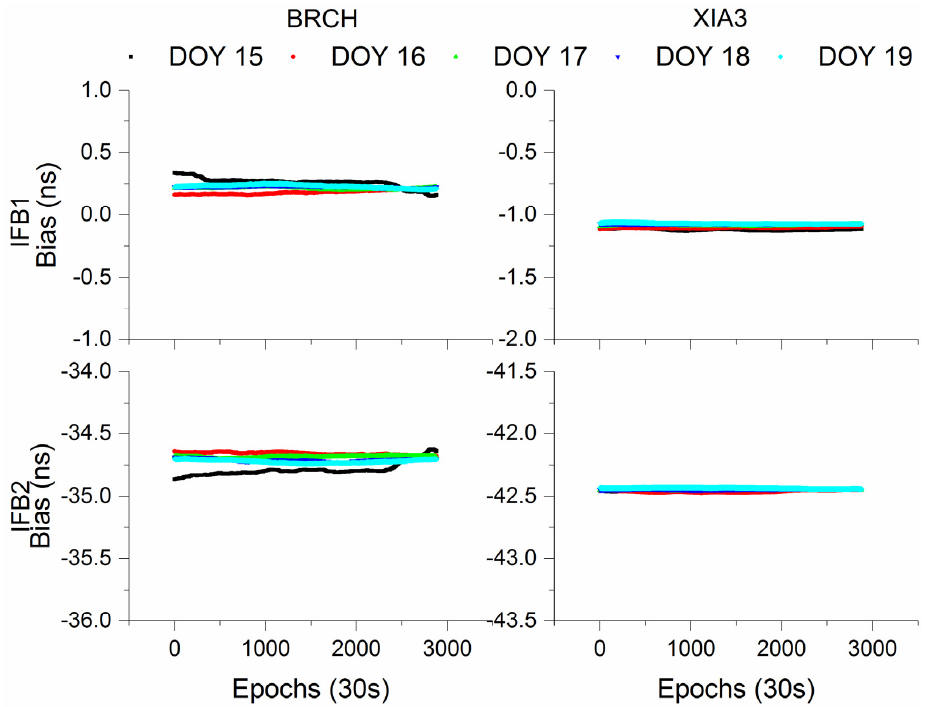
Figure 21. Analysis of two IFB parameters time series for BDS-3 UC models at BRCH and XIA3 stations. For Galileo IF1, IF2, and UC models, two, one and two additional parameters also need to be estimated. As previous mentioned, Figure 22 exhibits the IFB parameters time series obtained from Galileo UC models. The mean STD values of IFB parameters are (0.014, 0.004) ns for UC models at BRUX and PT11 stations. Similar to the IFB parameters of BDS-3 PPP model, the IFB values vary stable, with the small STD values.